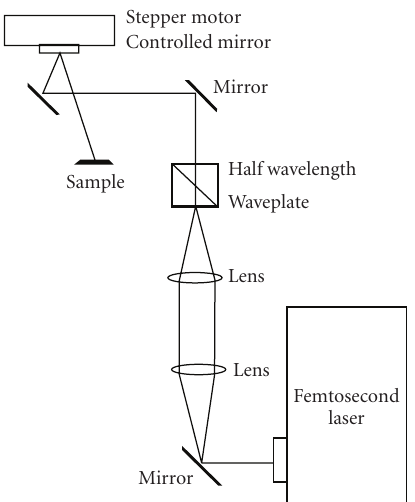
Figure 1: Setup for producing femtosecond laser ablation